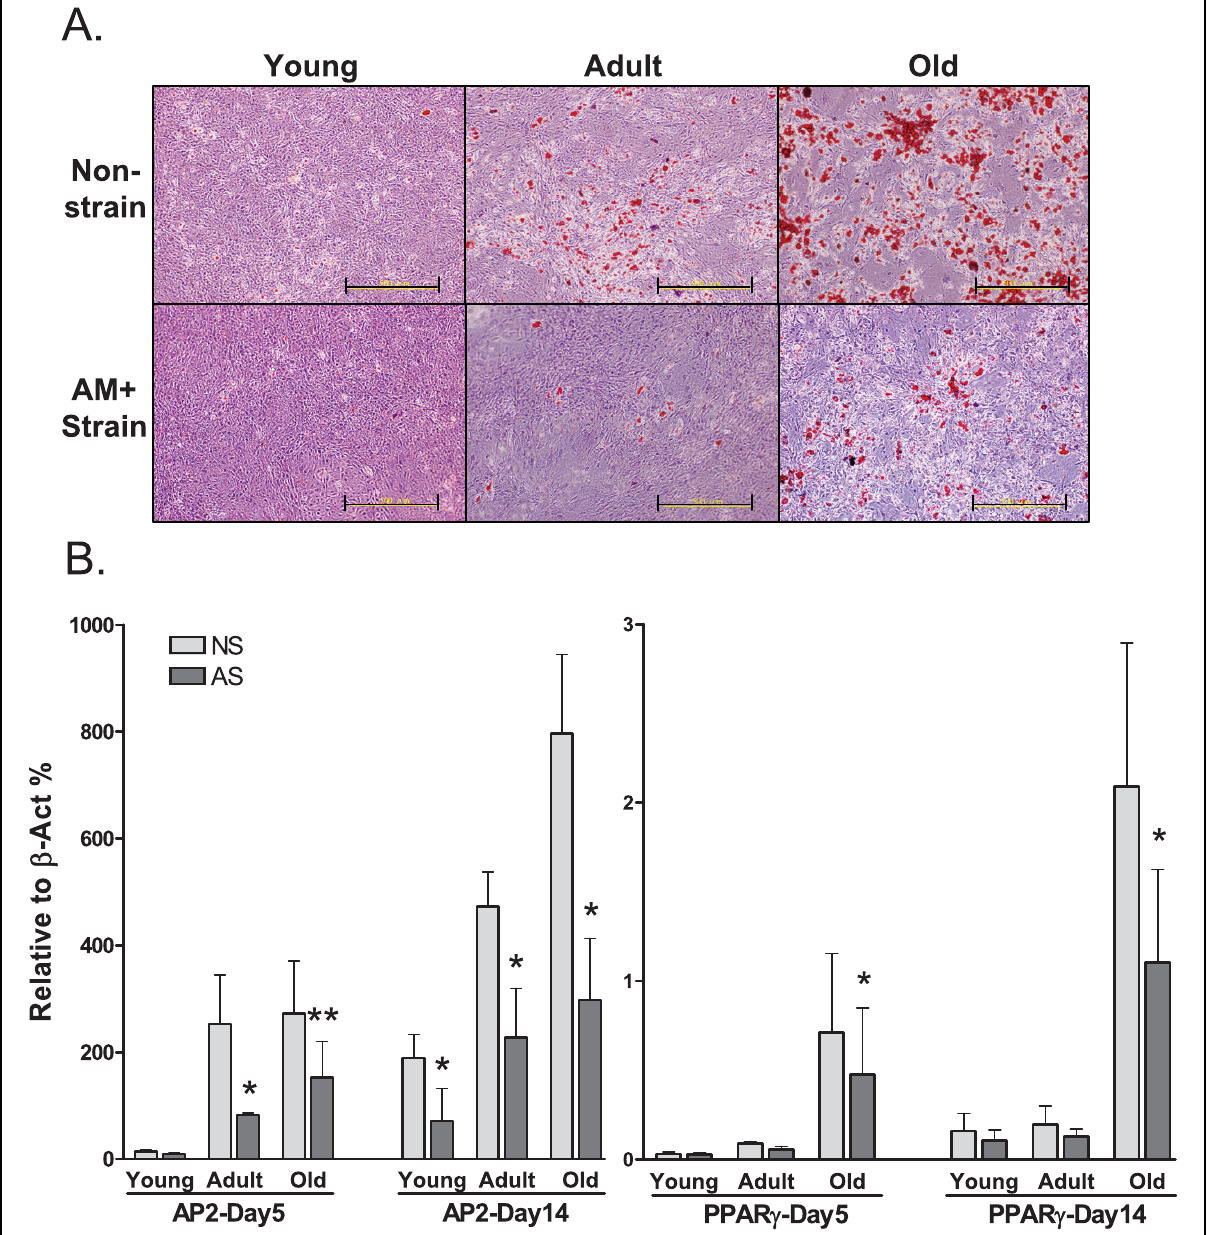
Figure 7 Strong inhibition of adipogenesis in ADSCs by simultaneously applying mechanical strain and adipogenic induction . A . Oil- Red O staining of ADSCs (AM+Strain) that were strained in adipogenic medium for the first 48 h and then by medium alone for the following 12 days. The non-strain cells were adipogenically induced for 14 days. Scale bars = 500 μ m. B . AP2 and PPAR g expression in ADSCs (AS) subjected to simultaneous strain for 48 h and adipogenic induction for a total of 5 or 14 days. The non-strained cells (NS) were adipogenically induced for 5 or 14 days **: P < 0.01, *: P < 0.05, N = 3, compared ΔΔ CT to NS